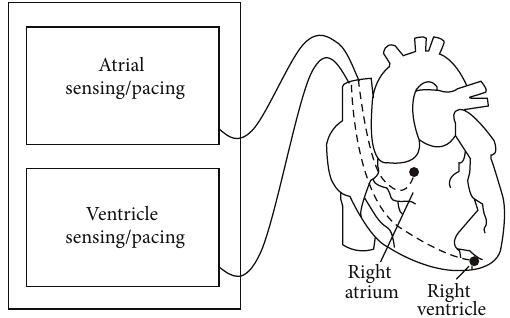
Figure 1: The interface between a heart and a DDD mode pace-